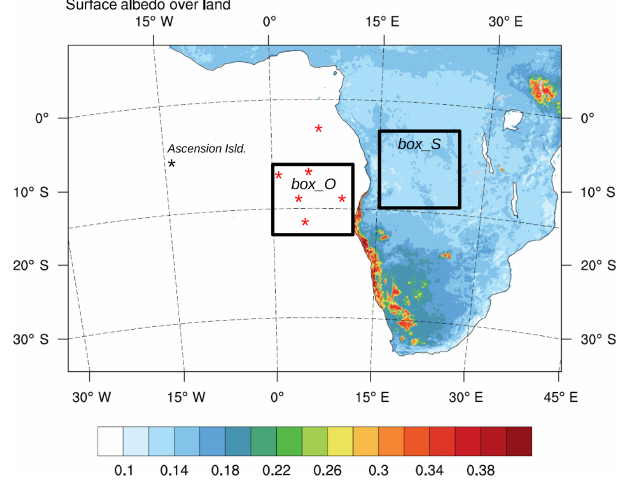
Figure 1. Domain defined for the ALADIN-Climate model simu- lations (here, the surface albedo is represented). The two different boxes (box_O and box_S) and Ascension Island are indicated. Red stars represent the localization of different profiles studied in the “comparison with HSRL-2 extinction”